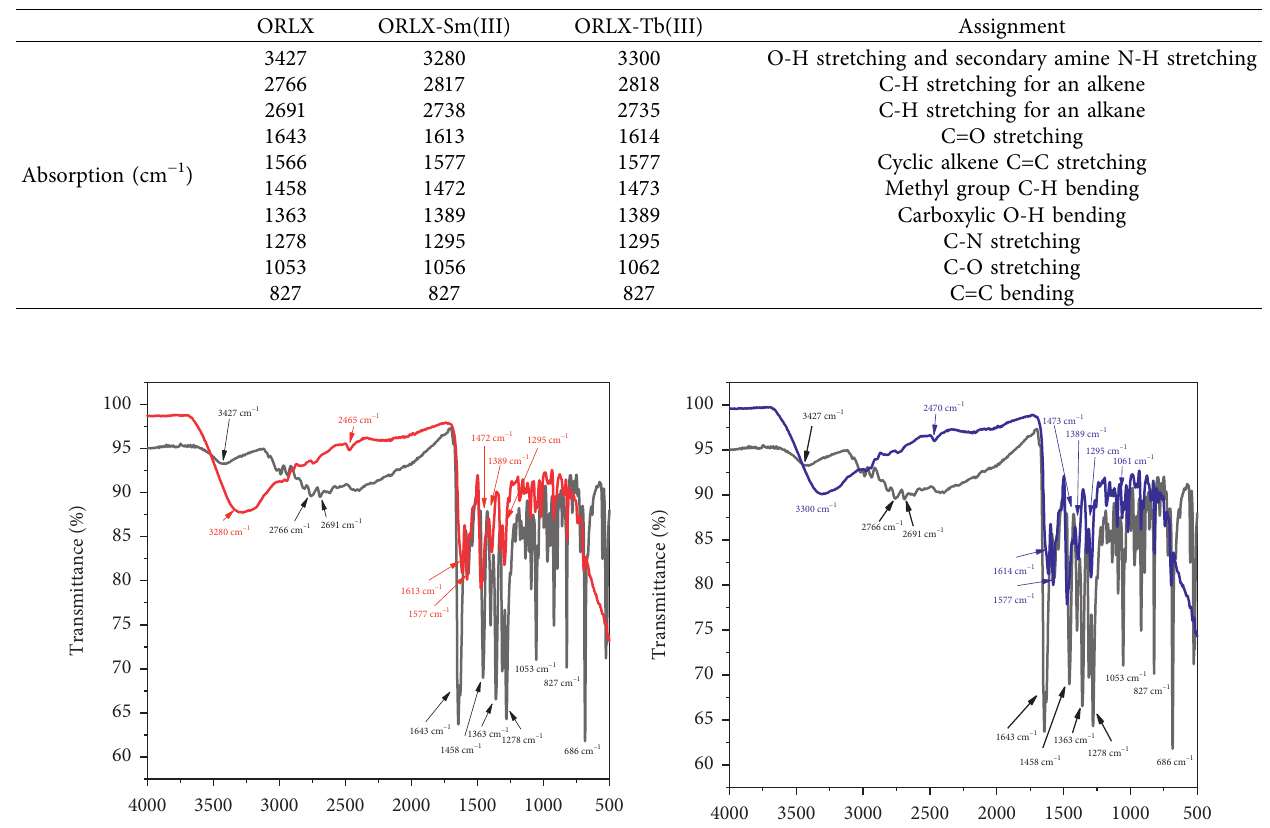
Table 4: FT-IR peak assignment for ORLX, ORLX-Sm(III), and ORLX-Tb(III) complexes.